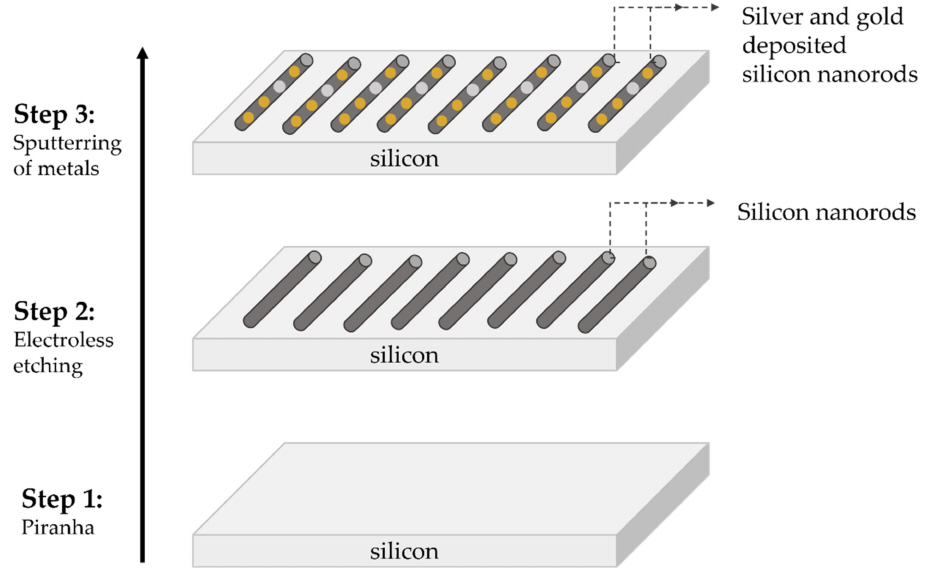
Figure 1. Schematic representation of the different processes of fabrication. 1—cleaning process, 2—Electroless etching, and 3—Sputtering of gold and silver